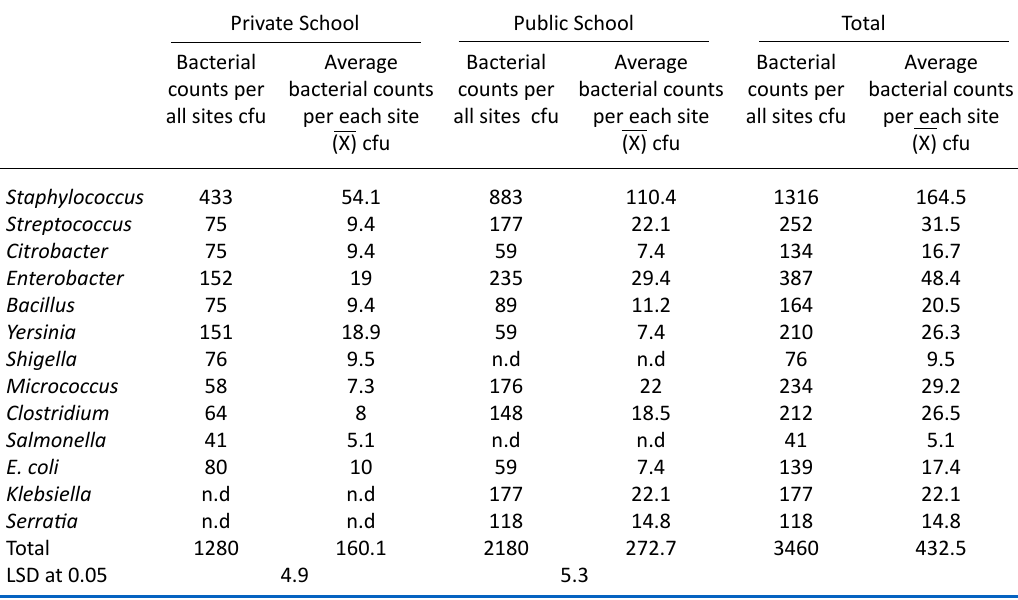
table 3. Spread and distribution of bacterial strains in relation to the sites in the two